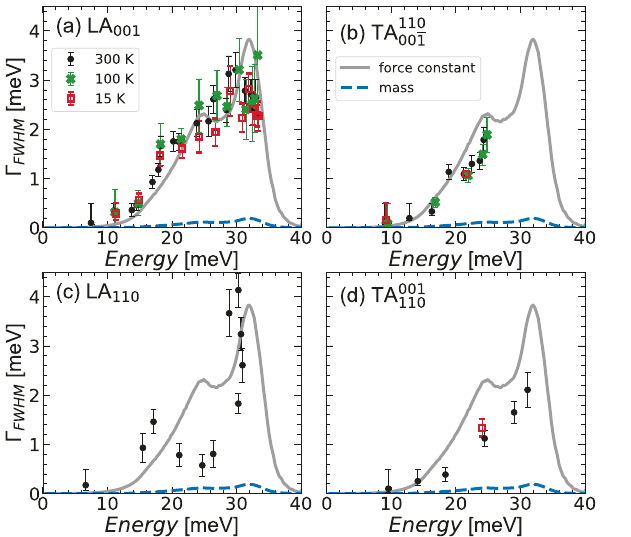
Fig. 7 | Perturbation theory modeling of phonon linewidths. Intrinsic phonon linewidths, measured by inelastic X-ray scattering at three temperatures for ( a ) , ( c ) LA 110 , and ( d ) TA 001 100 , reported as a function of energy and LA 001 , ( b ) TA 110 001 compared with a perturbation theory calculation of the broadening, based on calculated mass fl uctuations and estimated force-constant fl uctuations.